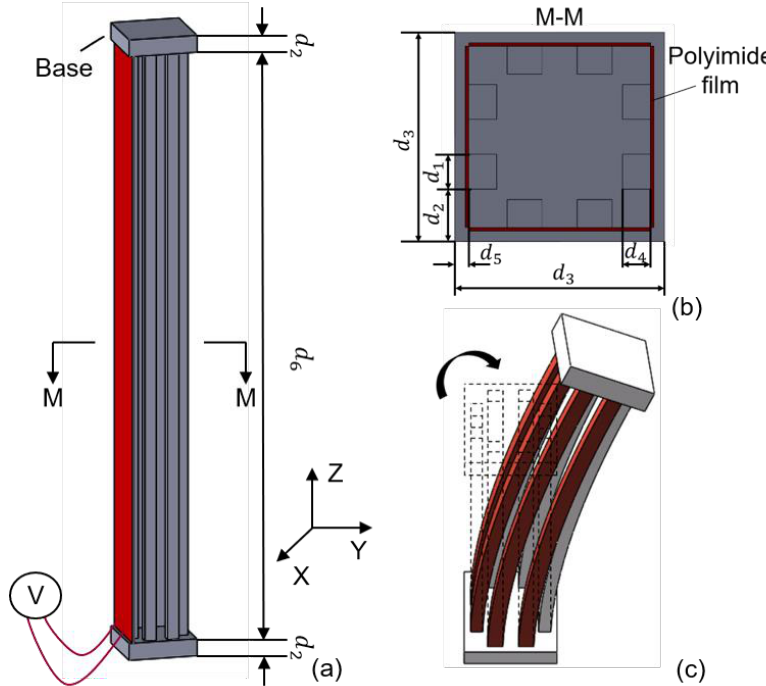
Figure 2. The structure of the 3D U-shaped electrothermal actuator. ( a ) Structure of the 3D U-shaped electrothermal actuator; ( b ) Sectional view of 3D U-shaped electrothermal actuator; ( c ) The 3D U-shaped actuator in bending.